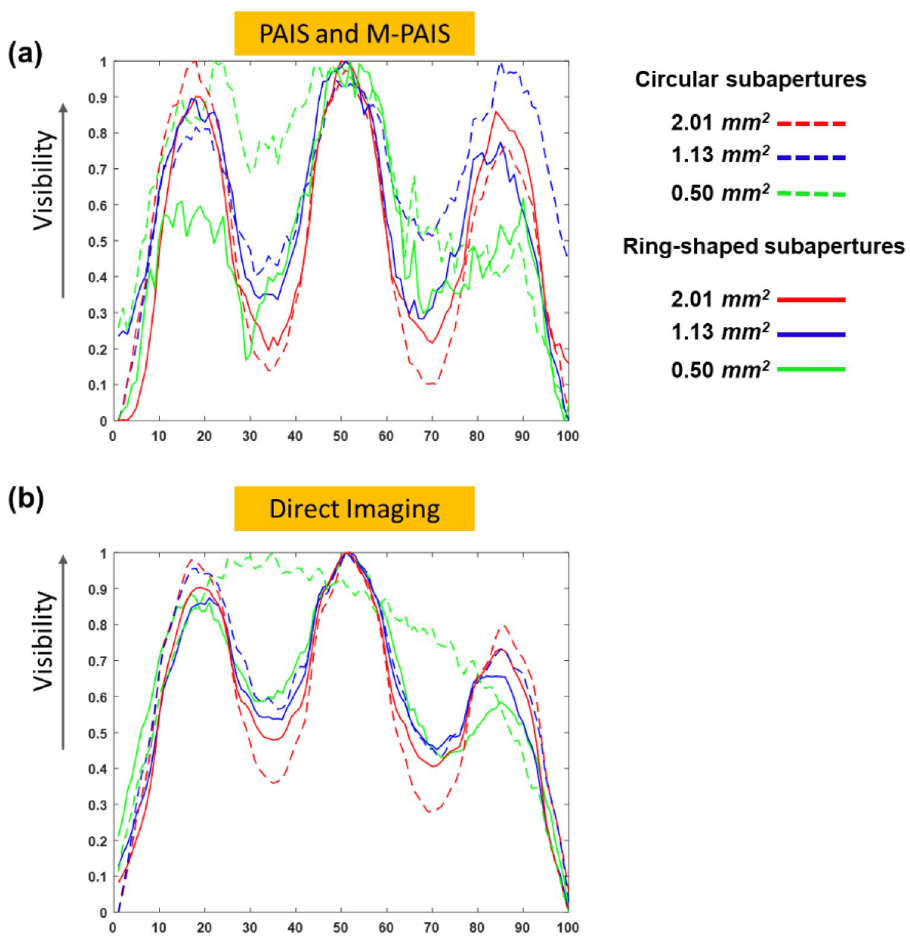
Figure 10. Visibility plots for ( a ) PAIS and M-PAIS and ( b ) direct imaging for circular subapertures and ring